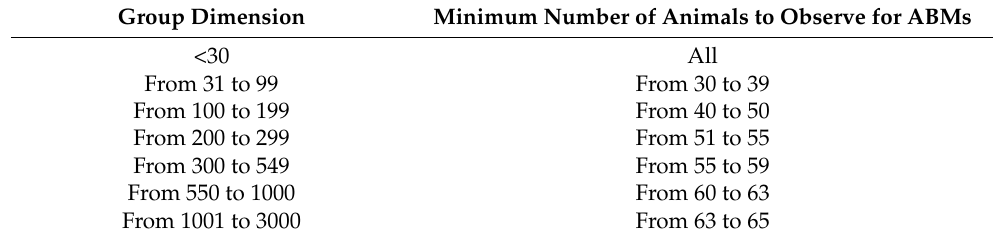
Table 3. Minimum number of animals to observe for ABMs. Group Dimension Minimum Number of Animals to Observe for ABMs